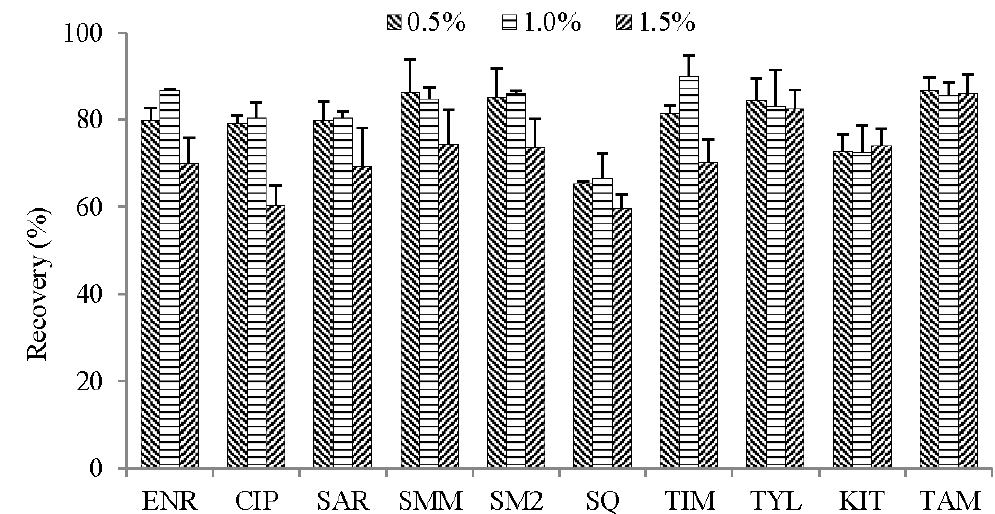
Figure 2. Influence of different percentages of acetic acid in acetonitrile on the recoveries of compounds in the chicken muscle sample at the spiked 50 μ g kg − 1 ( n = 5).